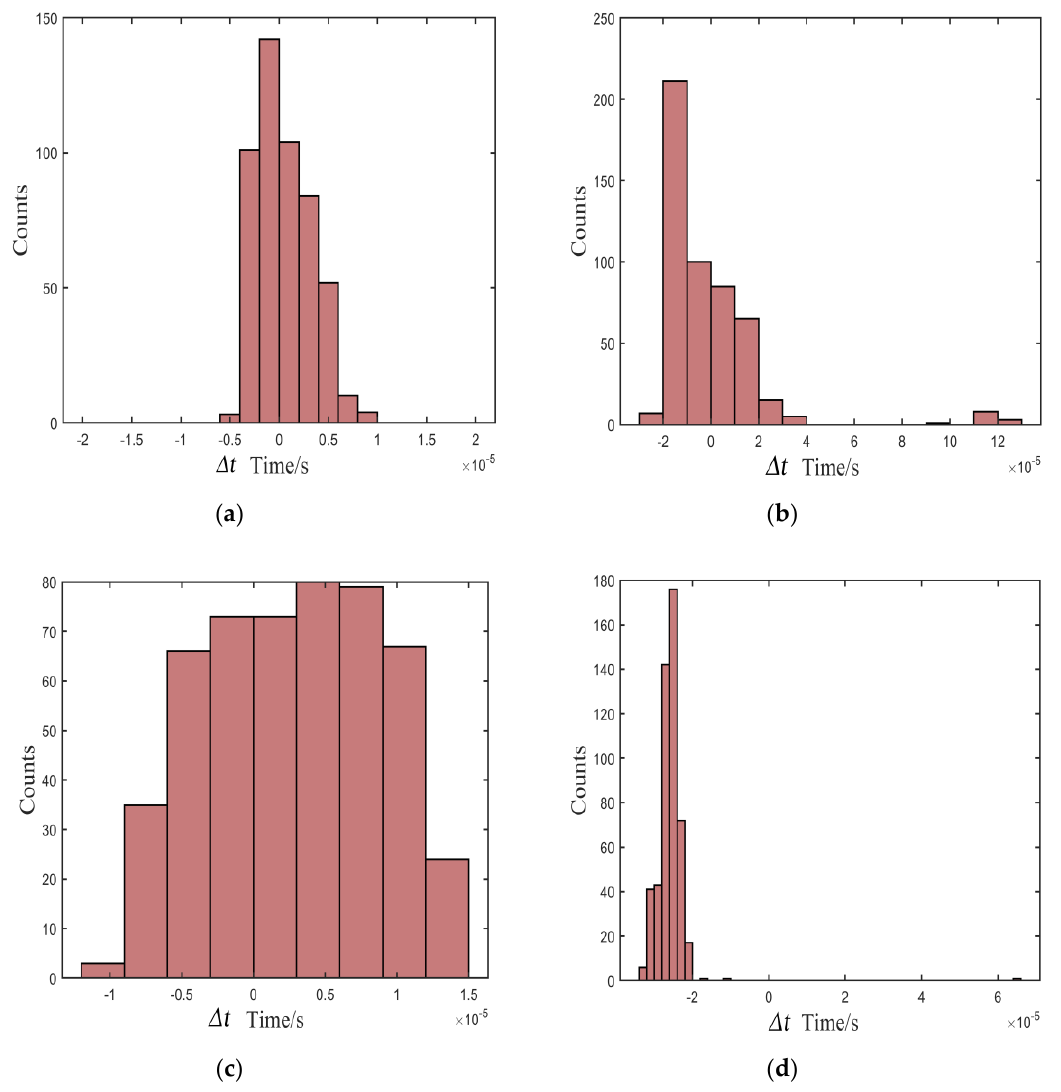
Figure 9. Distribution of deviation in the environment of 0 dB: ( a ) proposed, ( b ) Kurz, ( c ) TKEO, and ( d ) high-order statistics methods.